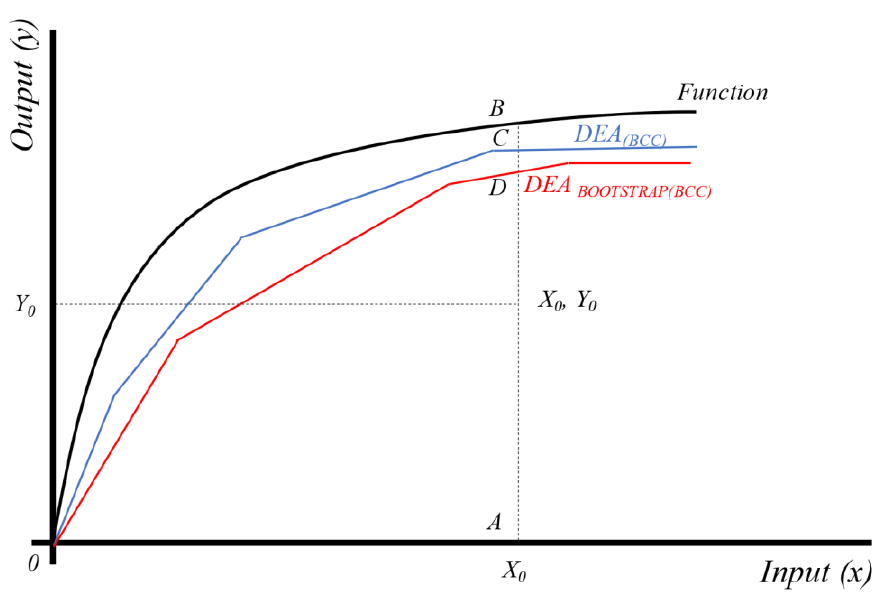
Figure 1. Graphical representation of the DEA-bootstrapping model output orientation. Source: based on (Gil Ropero, Turias Dominguez, and Cerbán Jiménez 2019 [25]).